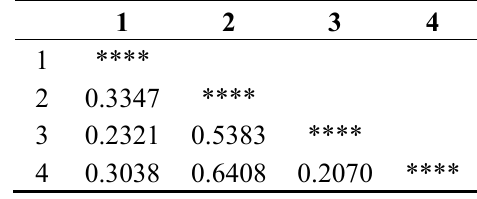
Figure 2. Biplot of the principle coordinates analysis of 30 T. ciliata populations. Codes of populations follow those given in Table 1. Table 4. The genetic distances among the four clusters of T. ciliata.